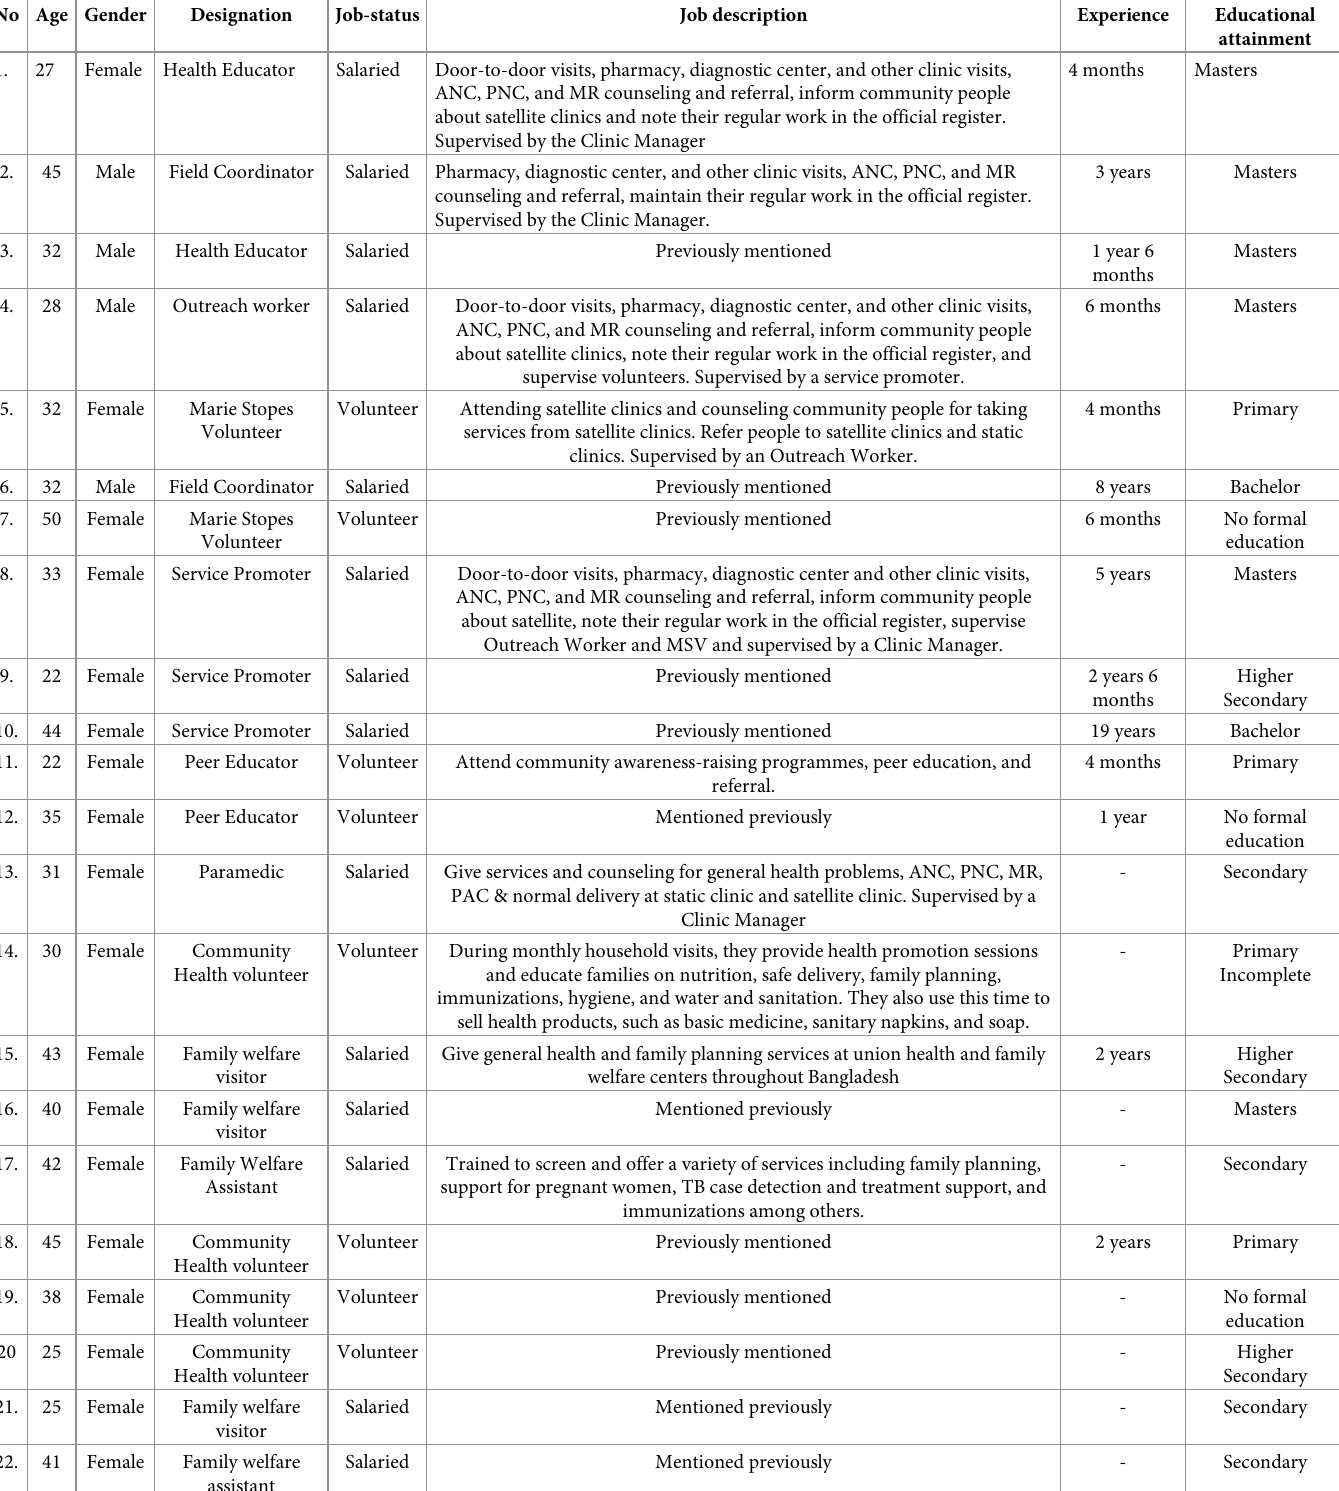
Table 1. Characteristics of the